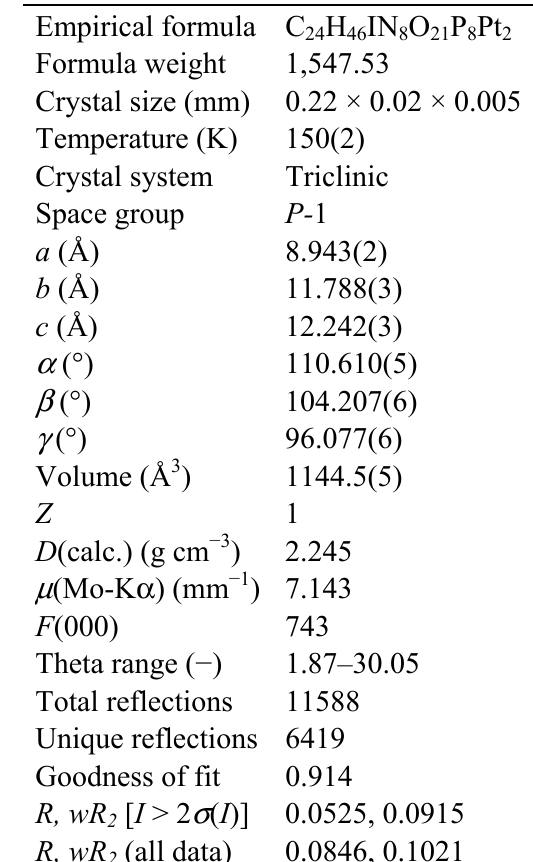
Table 1. Crystallographic data and structural refinement parameters for 1